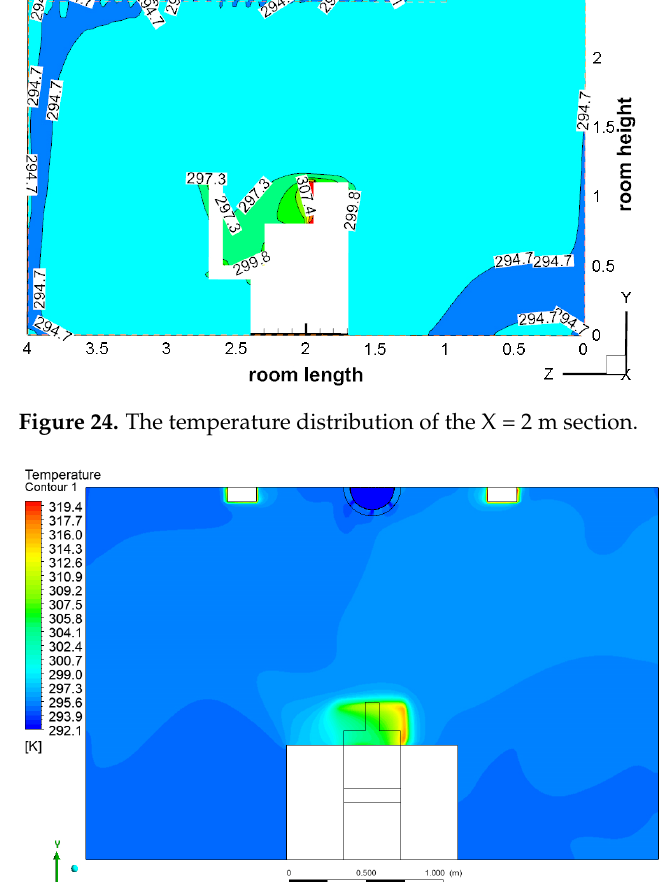
Figure 25. The temperature distribution of the Z = 2 m section.